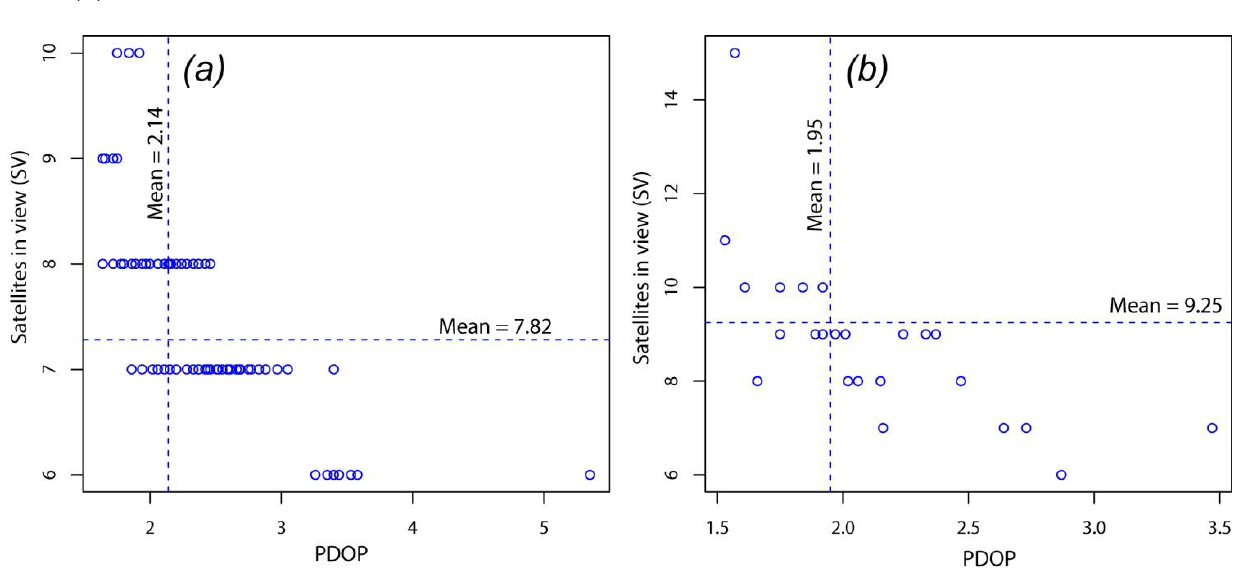
Figure 5. Scatter plots of satellites in view values vs. PDOP for ( a ) Anaguid and ( b ) Tebessa test